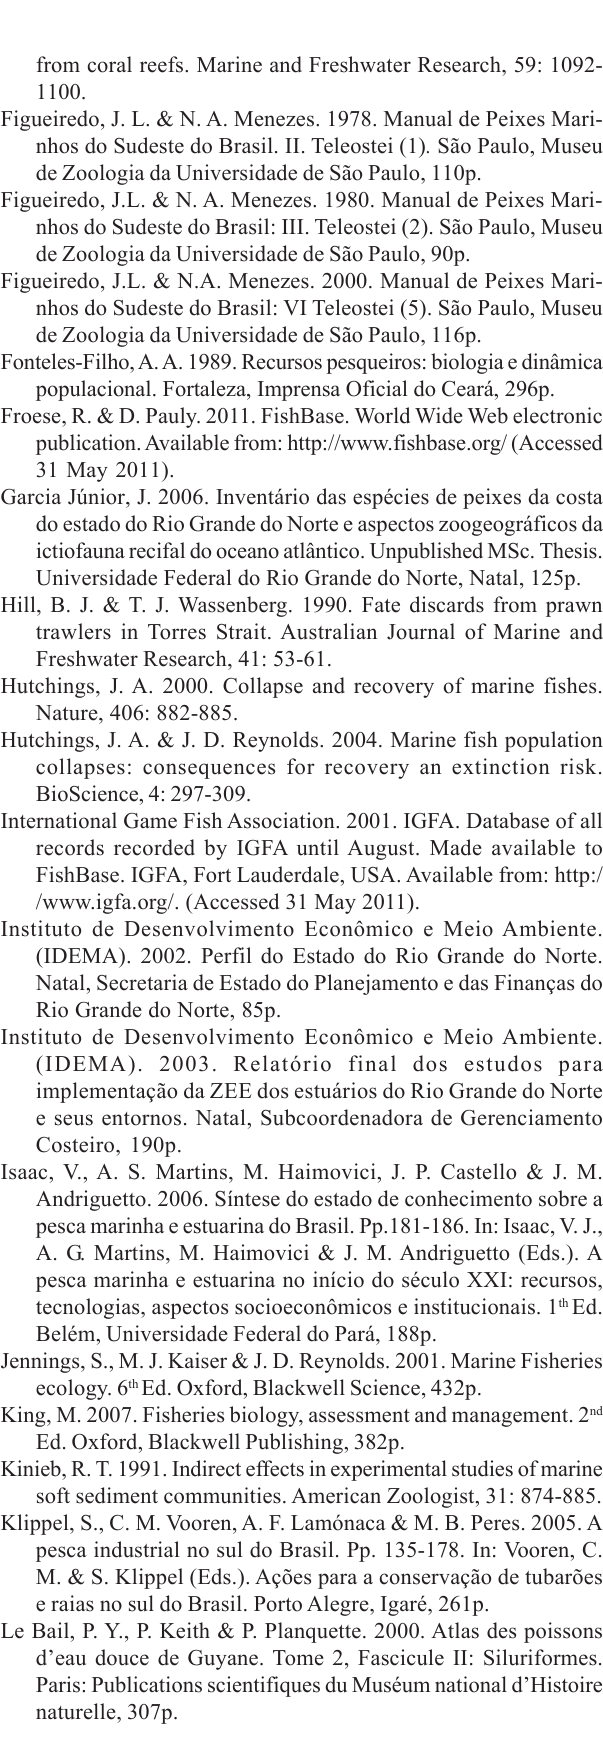
Figueiredo, J.L. & N. A. Menezes. 1980. Manual de Peixes Mari-